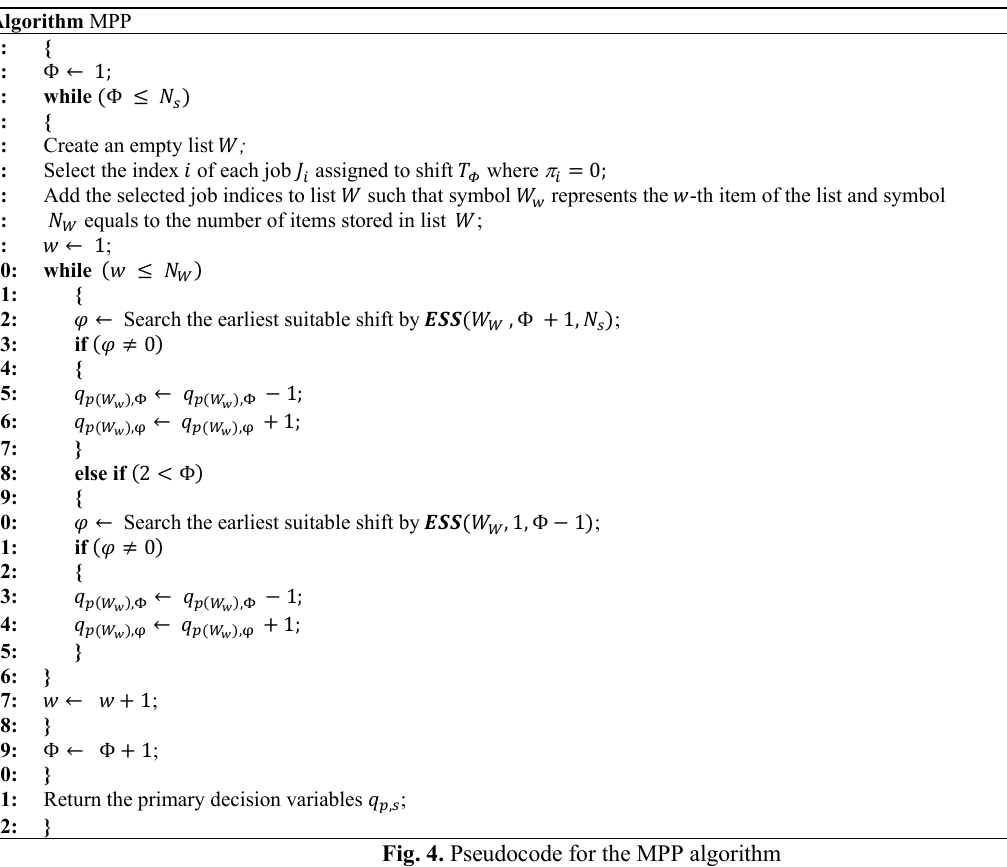
Fig. 4. Pseudocode for the MPP